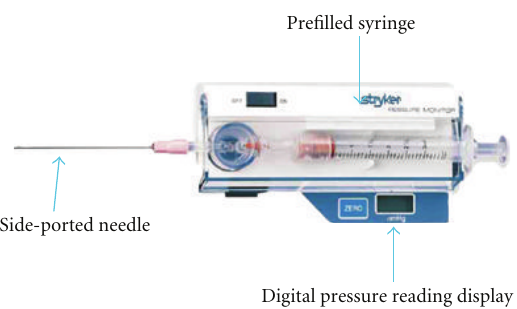
Figure 1: Stryker Intracompartment pressure-monitoring device.